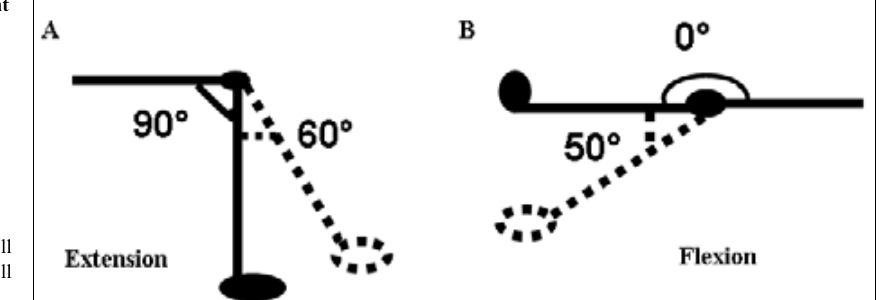
Figure 1. Estimation of knee joint position